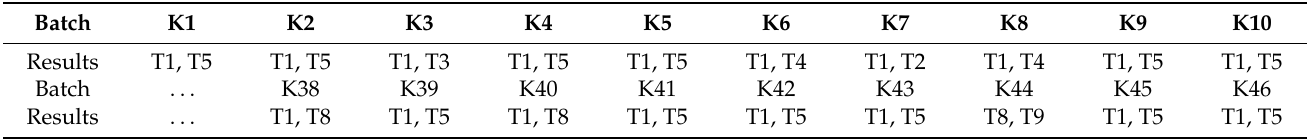
Table 4. Selection results of TSPs for each